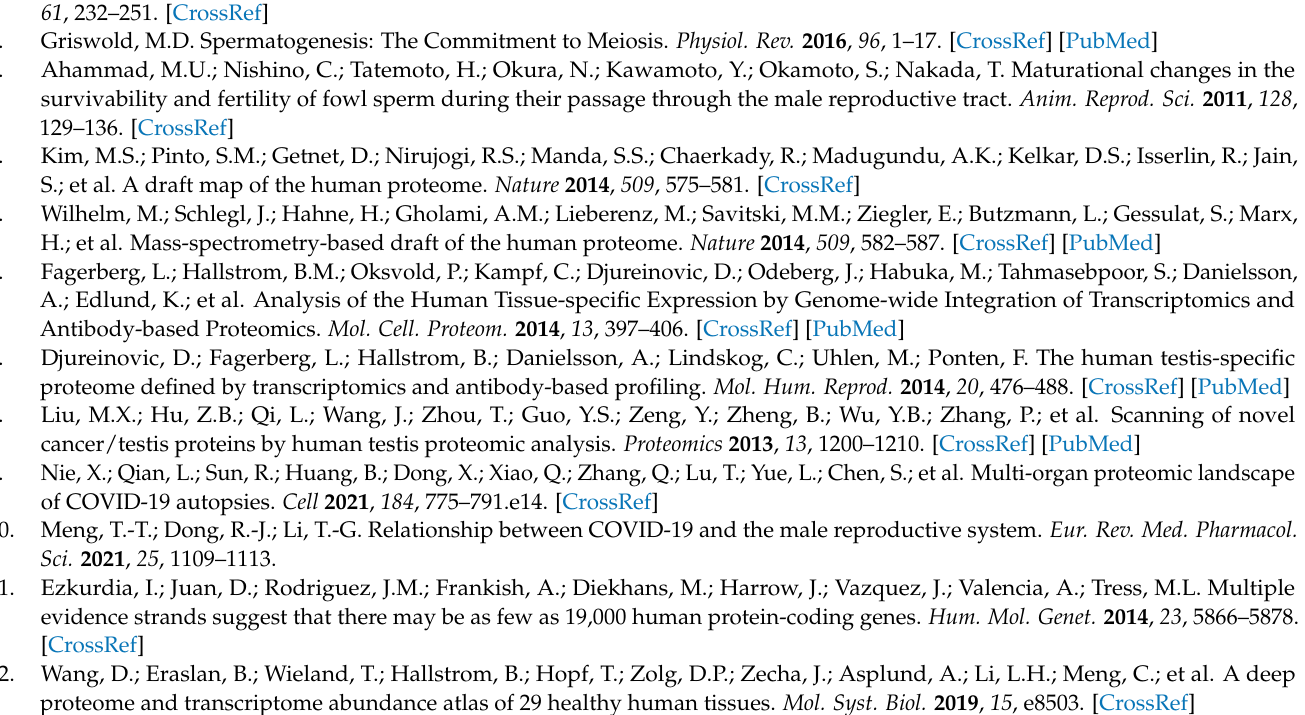
Table S3: HPA database, Table S4: MPs in proteomics profiling, Table S5: Peptides list of the 34 HBD, Table S6: Transition list of MRM